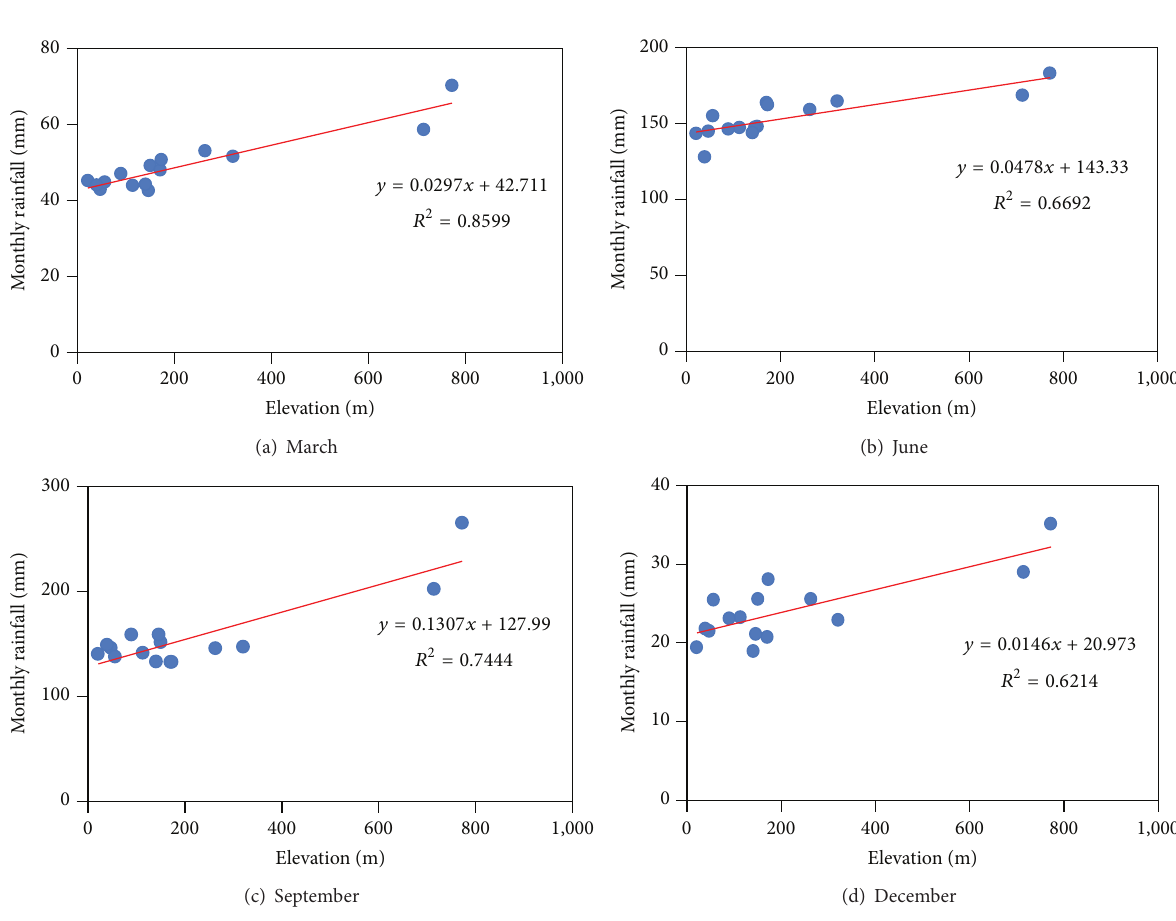
Figure 6: Relation between elevation and monthly rainfall.